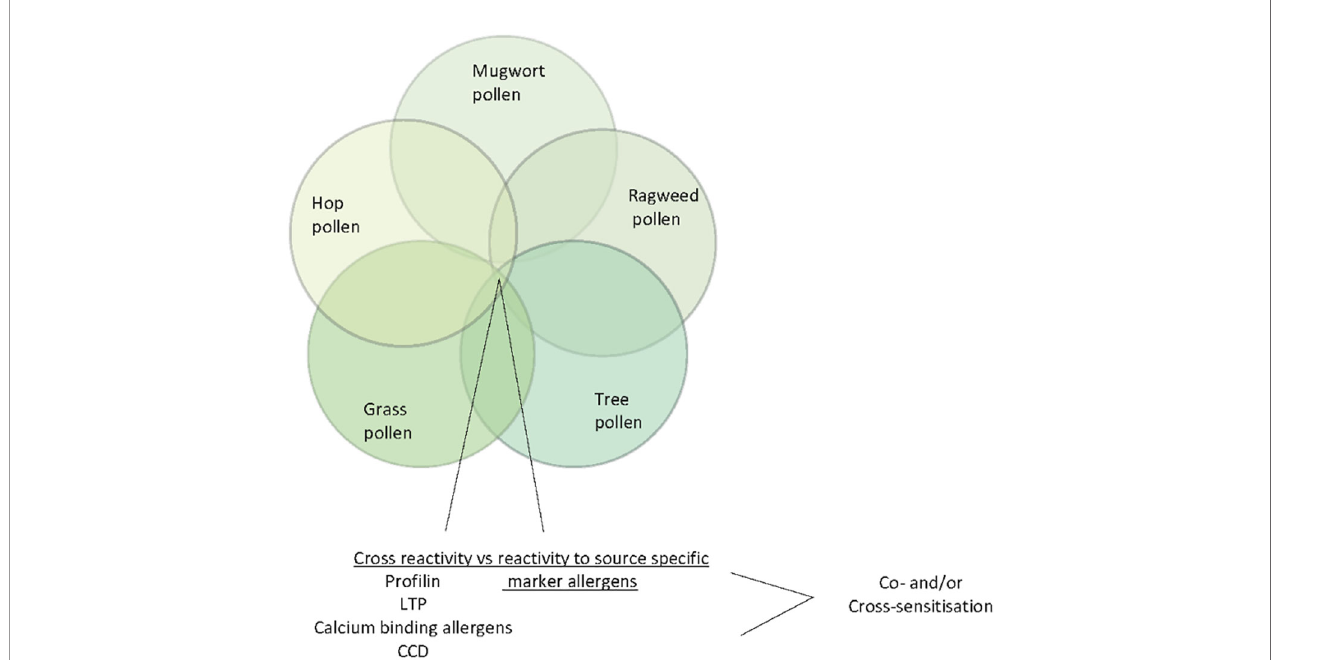
FIGURE 5 | Venn diagram of pollen allergen sources (ragweed, mugwort, tree pollen, hop pollen and grass pollen) indicating cross-reactive allergens/IgE-reactive antigens (pro fi lin, LTP, calcium-binding allergens and